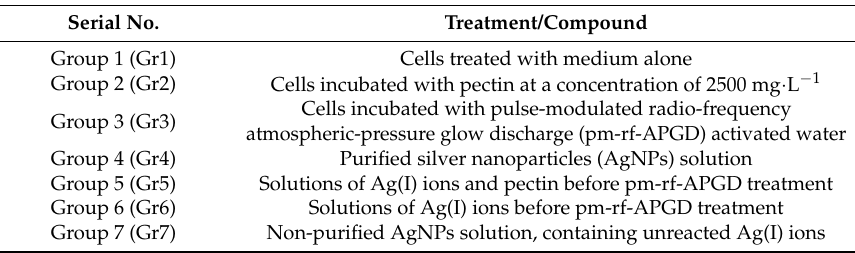
Table 2. Experimental groups used in the in vitro